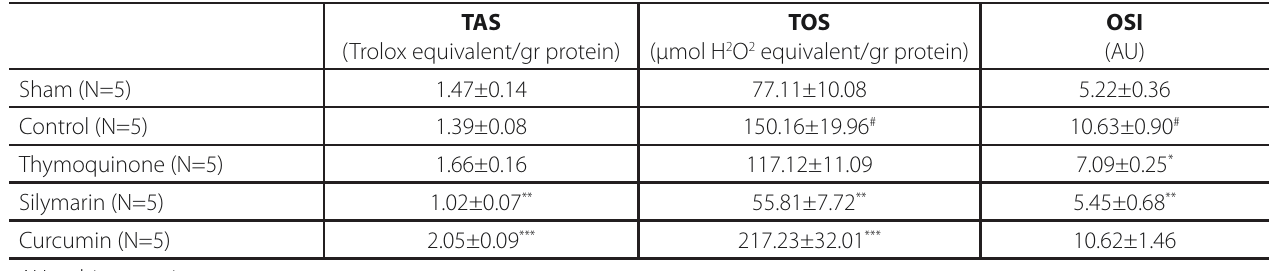
Table 1 . Total antioxidant status (TAS), total oxidant status (TOS), and oxidative stress index (OSI) measurements.